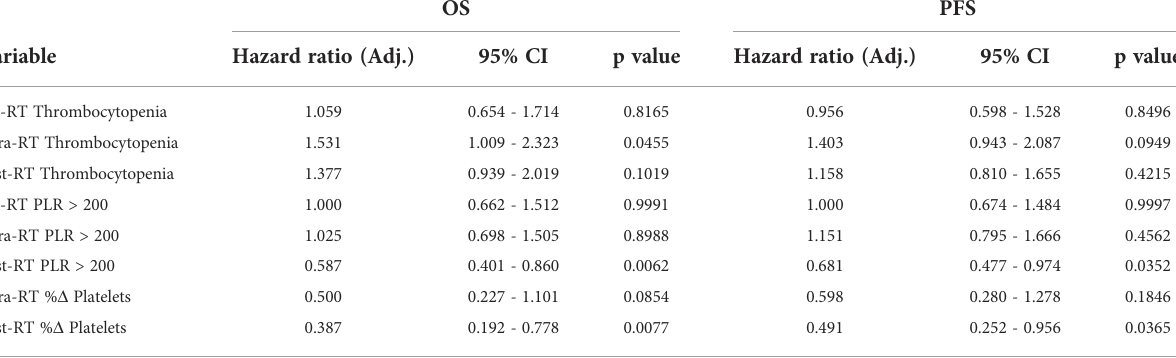
TABLE 3 Multivariable cox proportional hazards regression: Impact of platelets on OS and PFS. OS PFS Variable Hazard ratio (Adj.) 95% CI p value Hazard ratio (Adj.)